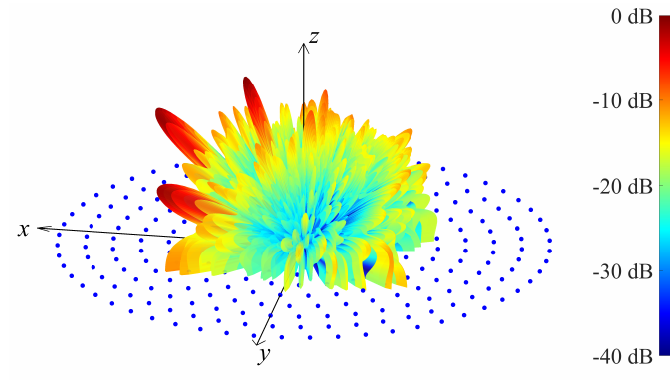
Figure 6. Third example: 3D pattern.